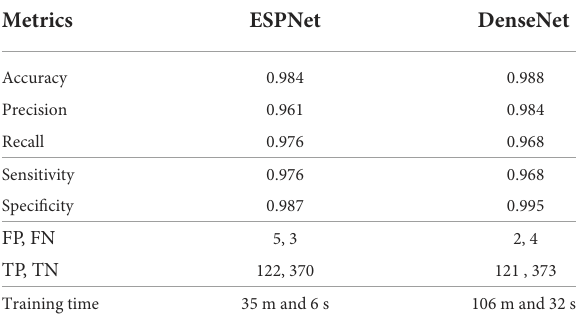
TABLE 2 Quantitative results of ESPNet and DenseNet on validation set for mitosis detection (This table was adapted from Nofallah et al.,